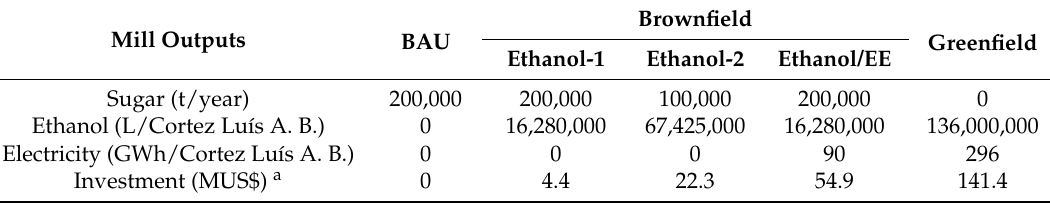
Table 4. Outputs from the sugar mill in the BAU and alternative scenarios in Mozambique and corresponding investment